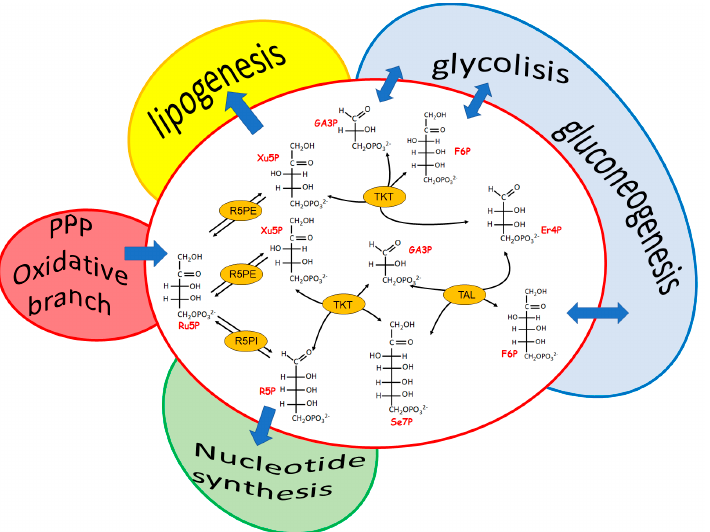
Figure 2. The reversible branch of PPP. The links among the reversible branch of PPP and relevant metabolic pathways are highlighted. Ru5PI, Ru5P-isomerase; Ru5PE, Ru5P-epimerase; TKT, trans– ketolase; TAL, transaldolase.